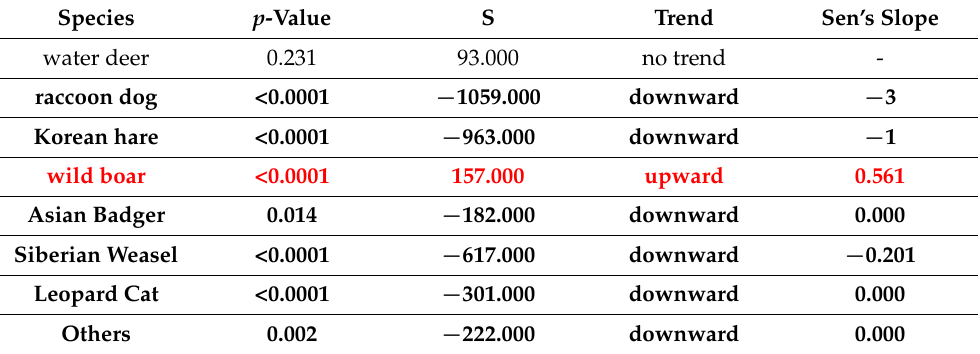
Table 3. Seasonal Mann–Kendall trend analysis for each species.